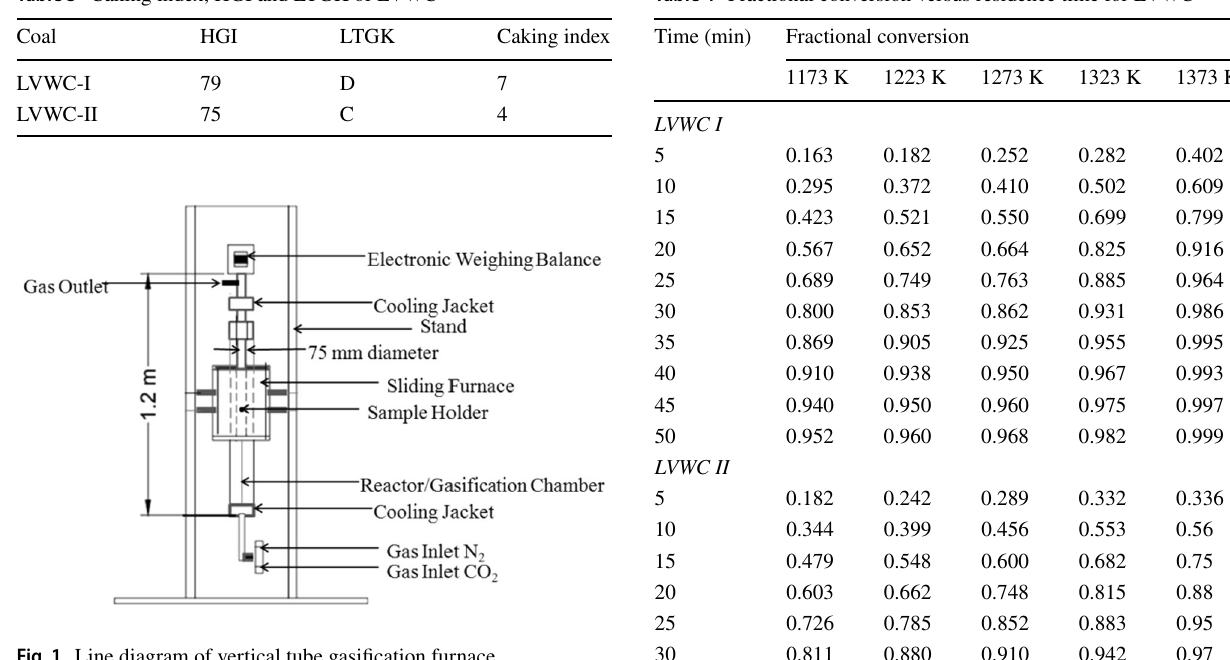
Fig. 1 Line diagram of vertical tube gasification furnace